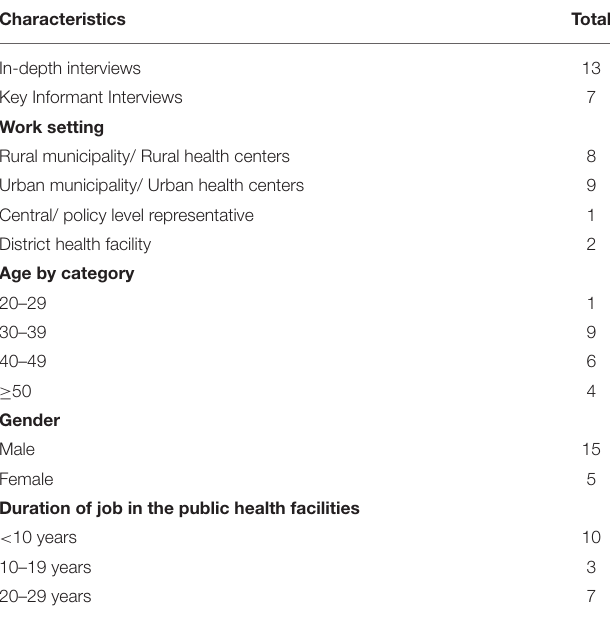
TABLE 1 | General characteristics of the In depth interview/Key infromant interviews participants.